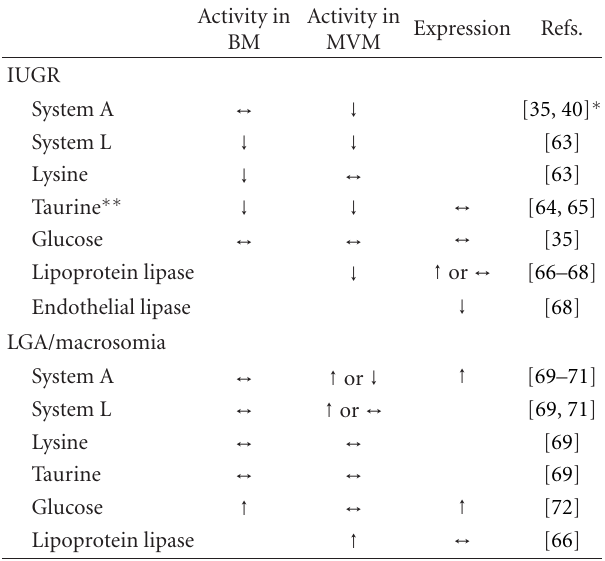
Table 1: Changes in BM or MVM activity or placental expression of nutrient transporters and lipases in pregnancies complicated by abnormal fetal growth. Arrows indicate direction of change compared to normal fetal